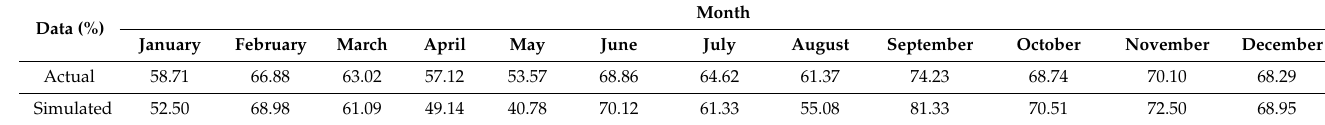
Table 1. Daily space heating energy consumption data of the 15th day of the months in 2020 for cases of leaky fans on in Montreal. Data (kWh) Actual Simulated Table 2. Daily indoor CO 2 concentration data of the 15th day of the months in 2020 for cases of leaky fans on in Montreal. Data ((kg/kg) × 10 − 4 ) Actual Simulated 8.01 Table 3. Hourly relative humidity (RH) data of the 15th day of the months in 2020 for cases of leaky fans on in Montreal. Data (%) Actual 58.71 Simulated 52.50